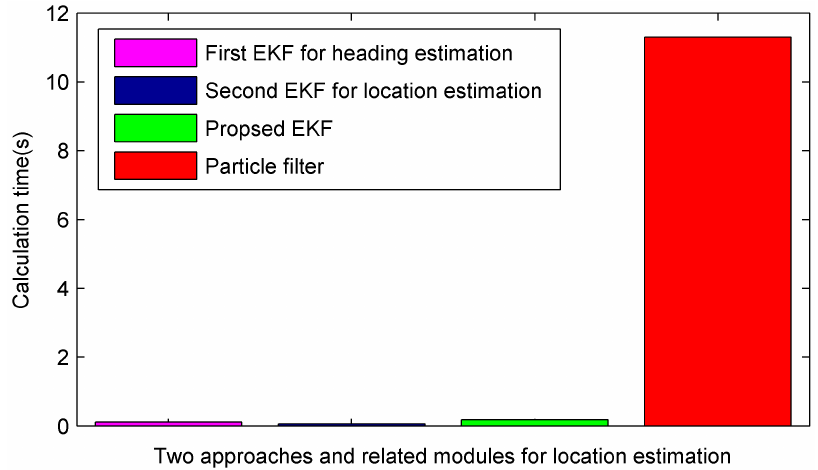
Figure 9. Comparisons of the calculation time for location estimation per step between a particle filter and the proposed EKF based approach, whose two main modules are: first EKF for heading estimation; and second EKF for location